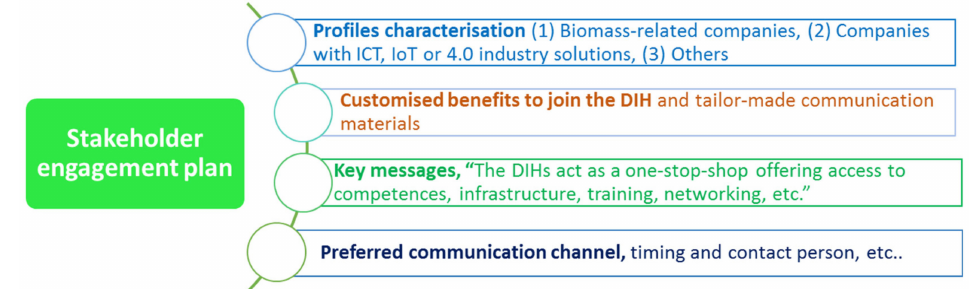
Figure 5. Key aspects of the stakeholder engagement plan.